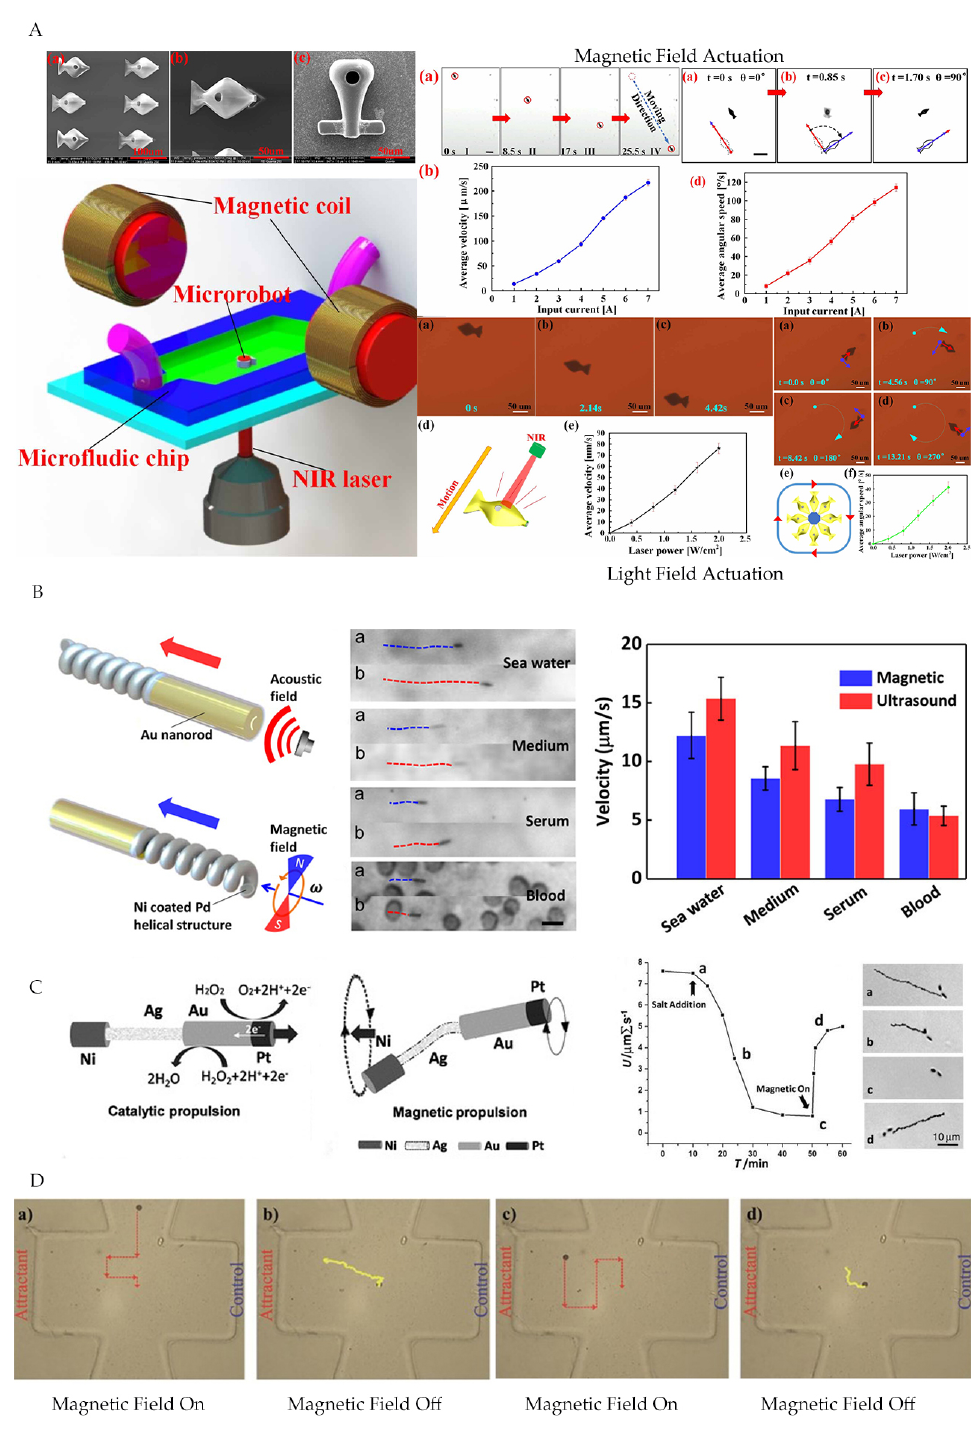
Figure 6. ( A ) Light/magnetic field hybrid actuated bionic microrobot. Reproduced with permission from ref [54]; published by Insitute of Physics Publishing, 2021. ( B ) Magnetically/acoustically hybrid actuated nanomotor [55]. Reprinted (adapted) with permission from ref [55]. Copyright 2015 American Chemical Society. ( C ) Catalytically/magnetically powered hybrid nanomotor. Reproduced with permission from [51]; published by John Wiley and Sons, 2011. ( D ) Microrobot actuated by hybrid magnetic field/flagellate bacteria. Reproduced with permission from ref [52]; published by John Wiley and Sons,